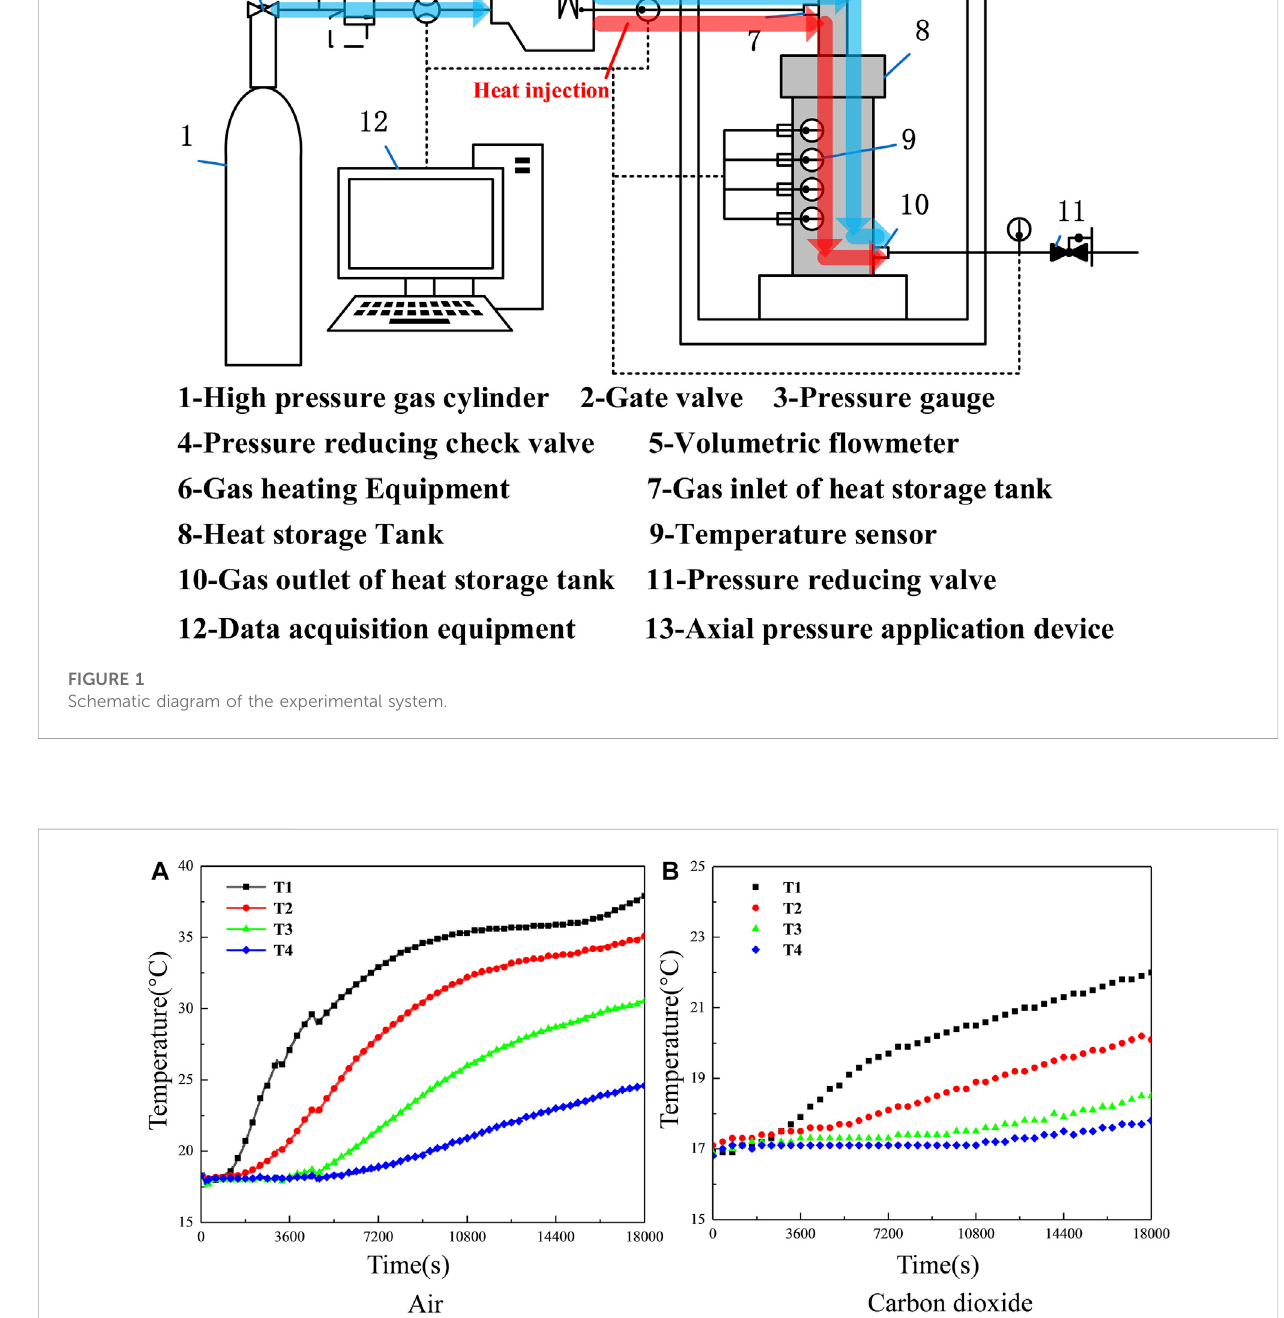
The schematic diagram of the experimental system is shown in Figure 1. The heat storage tank is fi lled with broken granite grains to form a rock packed bed, and axial pressure is applied to the packed